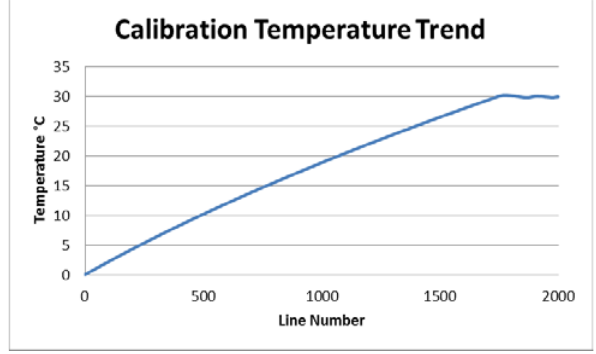
Figure 4. Calibration Flap Temperature trend